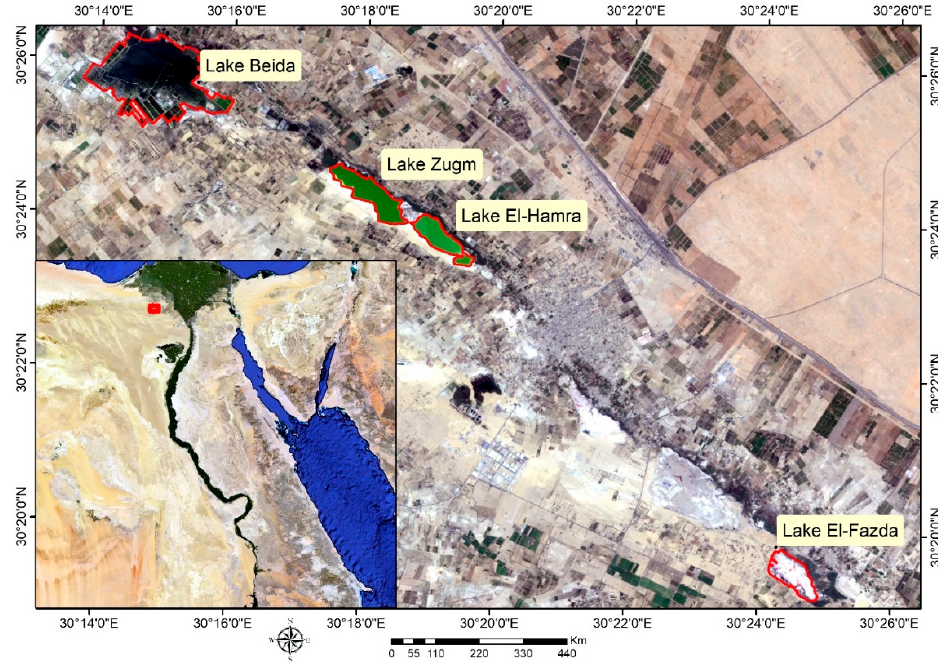
Figure 1. Location map of soda lakes from Wadi El-Natrun depression analyzed in the present study.